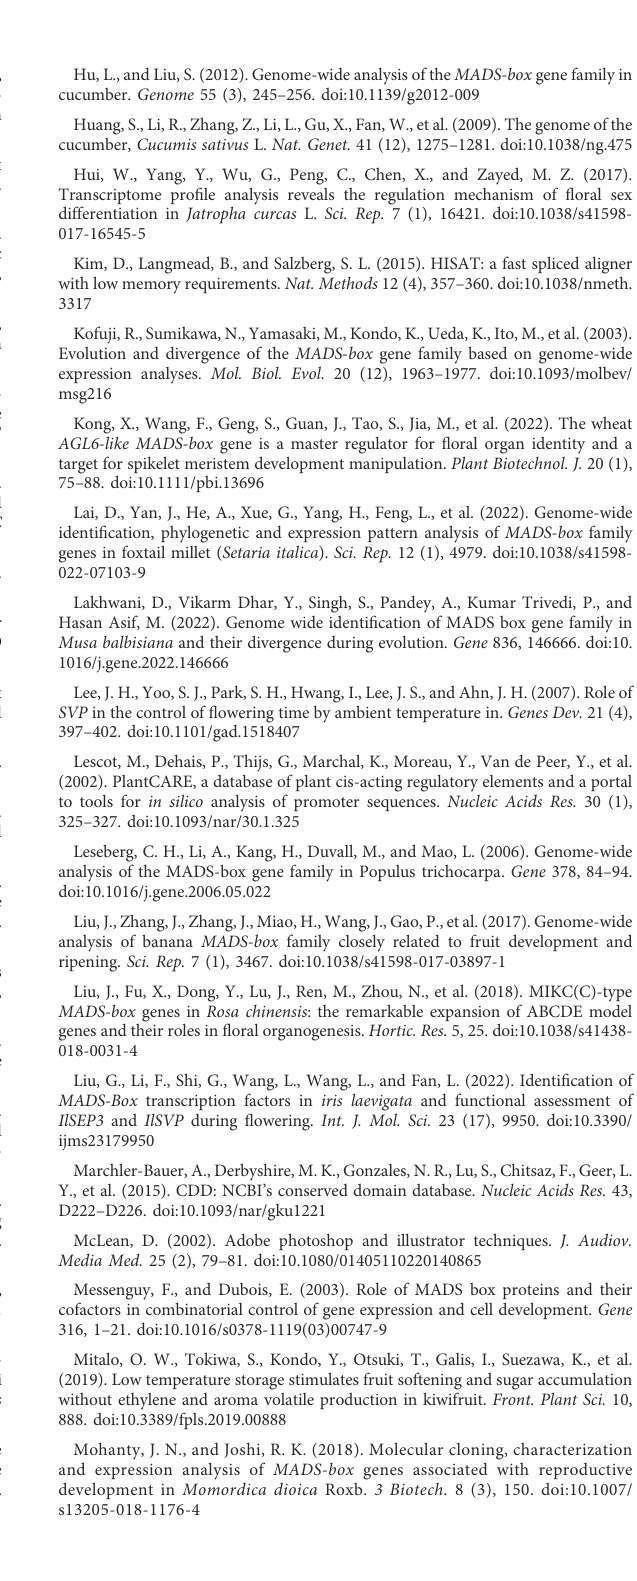
SUPPLEMENTARY FIGURE S2 Number of A. chinensis MADS-box genes on each